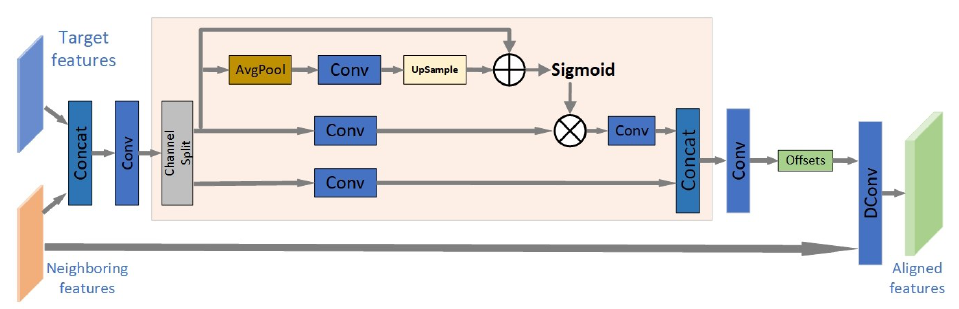
Figure 3. Our proposed pooled self-calibrated convolution (PSCC) module for feature